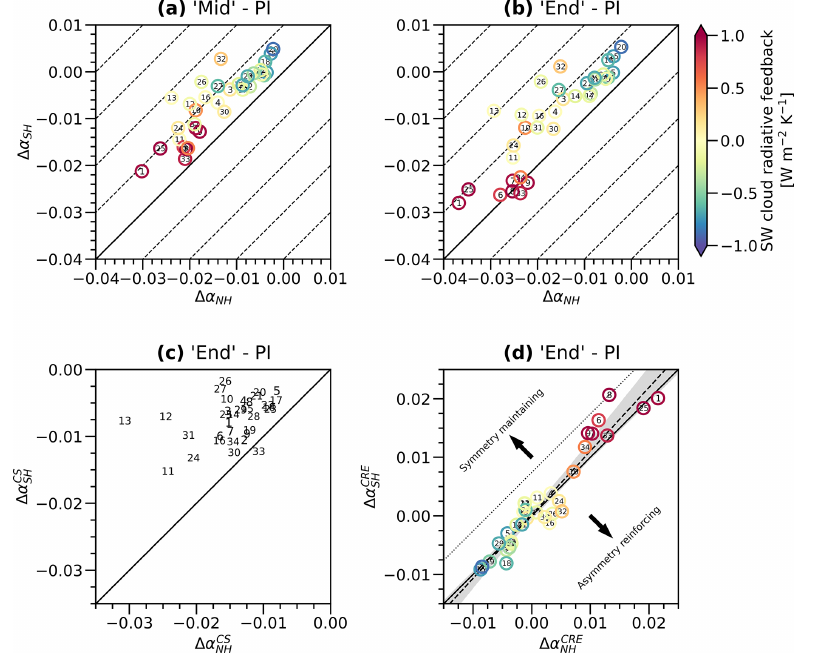
Figure 6. (a, b) Changes in the NH and SH hemispheric mean planetary albedo relative to their PI mean albedo ( (cid:49)α NH and (cid:49)α SH respec- tively) plotted against each other on a “symmetry” phase space for all models in the (a) Mid and (b) End periods. The thick diagonal line represents symmetry scaled to PI conditions, while each dashed line parallel to this represents a 1% hemispheric difference in albedo; models on the diagonal line remain close to their PI mean asymmetry. (c, d) Changes in NH and SH hemispheric mean (c) clear-sky albedo ( (cid:49)α CS ) and (d) SW CRE normalized by insolation ( (cid:49)α CRE ) between End and PI conditions. In (d) , the dotted line represents the multi-model mean clear-sky albedo asymmetry anomaly by the End period, and the dashed line depicts a linear regression among the models; shading represents the 95% confidence interval for the slope. Estimates of model SW cloud radiative feedback strengths are given by the color of the marker. Markers denote models as they are numbered in Table